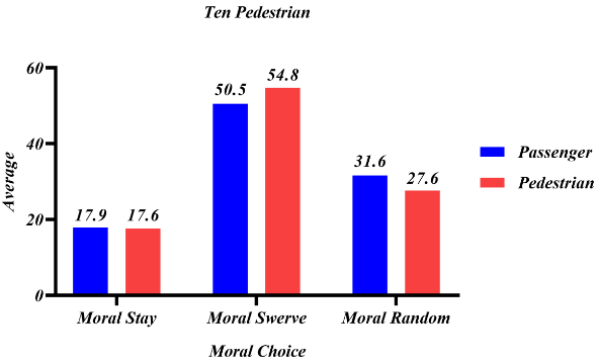
Figure 11. Mean values of participants’ evaluation scores for different moral choices when there were ten sudden pedestrian intruders.